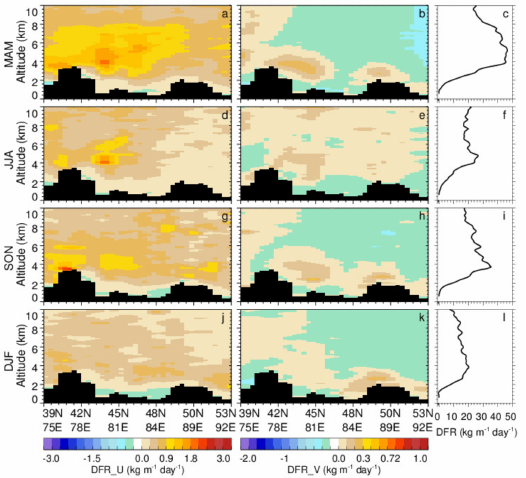
Figure 7. Same as the Figure 5, but for the cross-section of C2 in ( a – c ) spring (MAM: